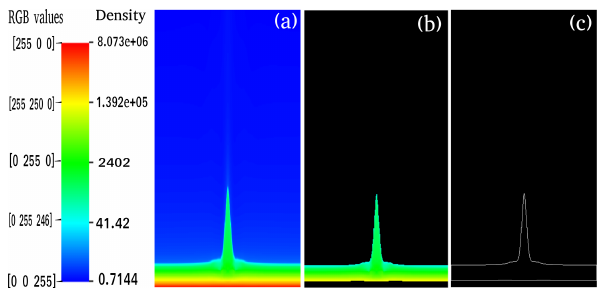
Figure 7. Automated detection of the plasma jet in the numerical simulation data to establish its time–distance profile and termination